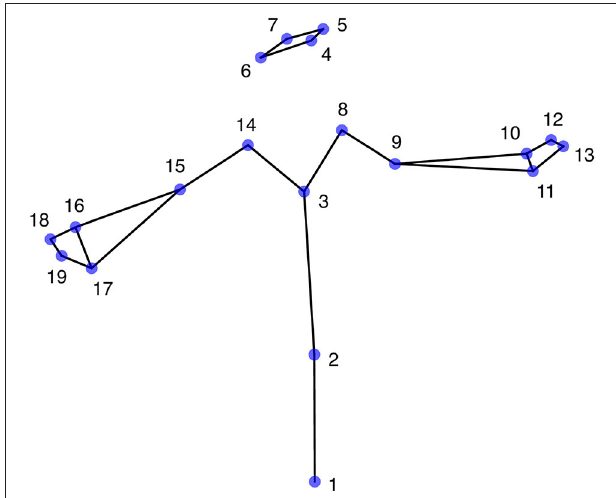
FIGURE 1 | The 19 upper-body markers in the “T” reference